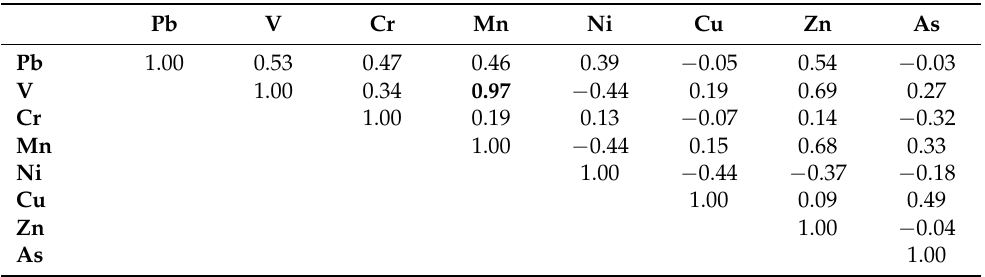
Table 3. Pearson’s correlation matrix among metals in BHA (N = 13; p < 0.05). Correlation coeffi- cients > 0.69 are indicated in bold.